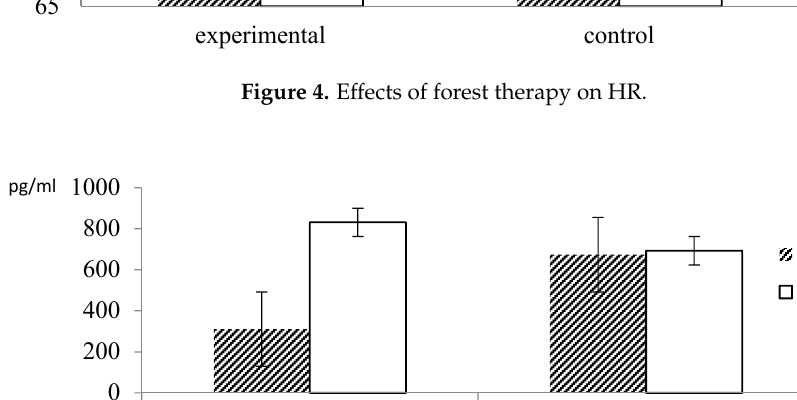
Figure 4. Effect on forest therapy on HR.